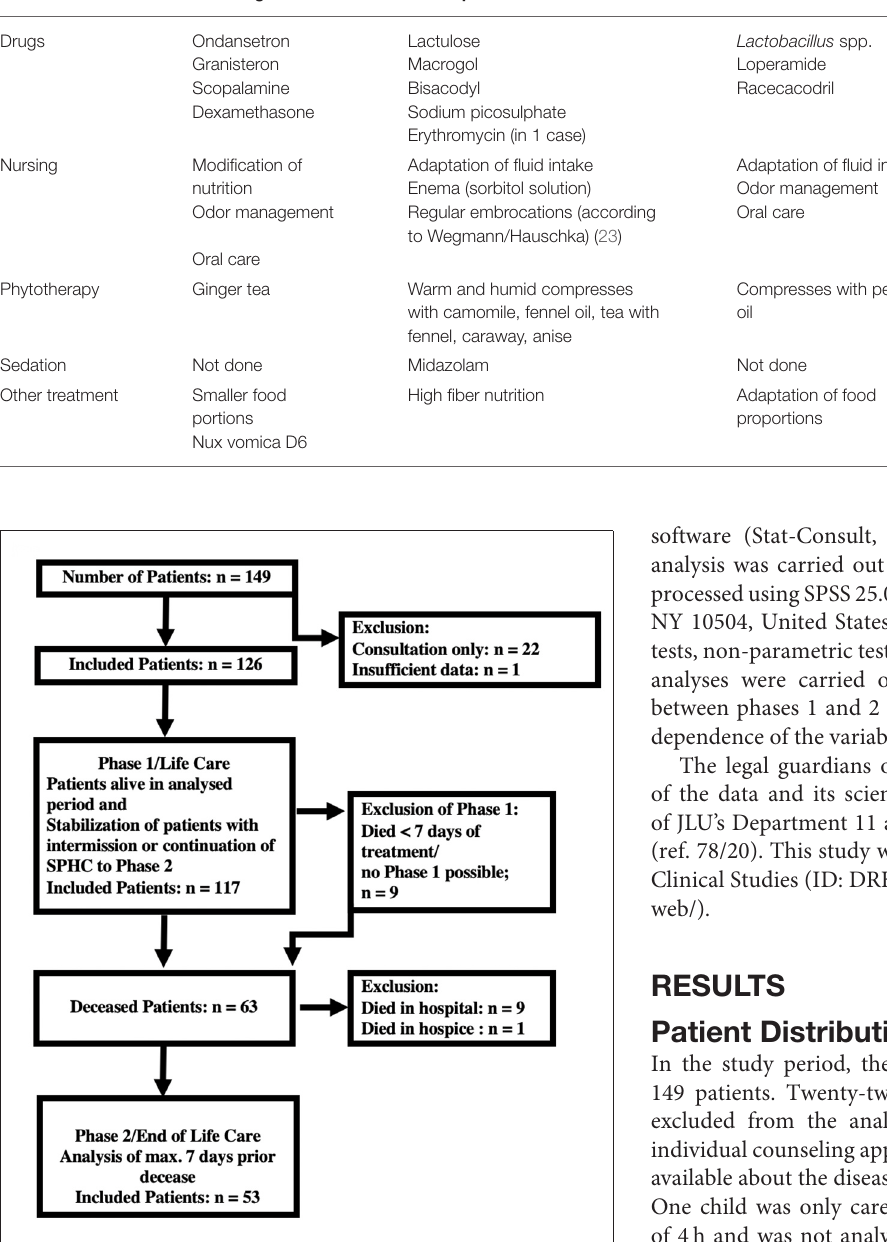
FIGURE 1 | Inclusion of